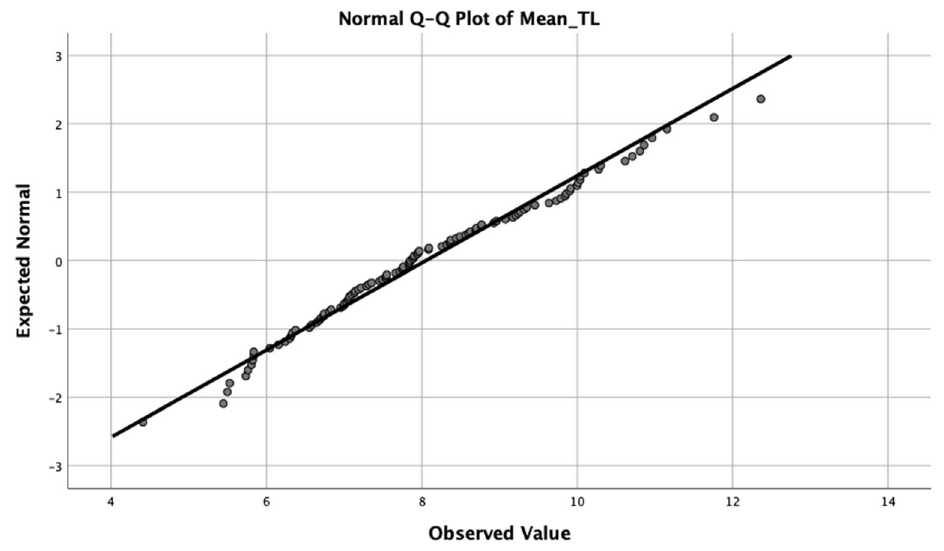
Figure 1. Q–Q plot of mean telomere length.